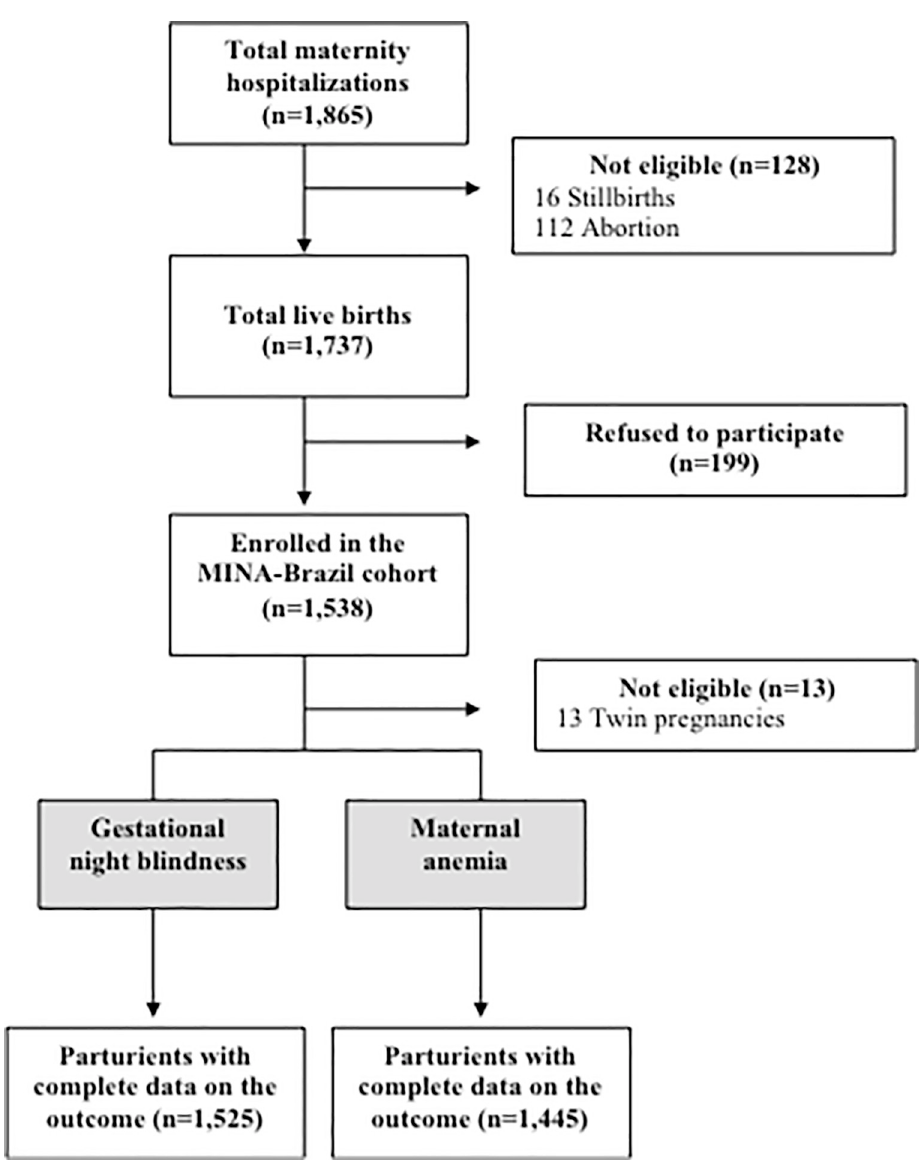
Fig 1. Flow-diagram of screening of participants and outcome